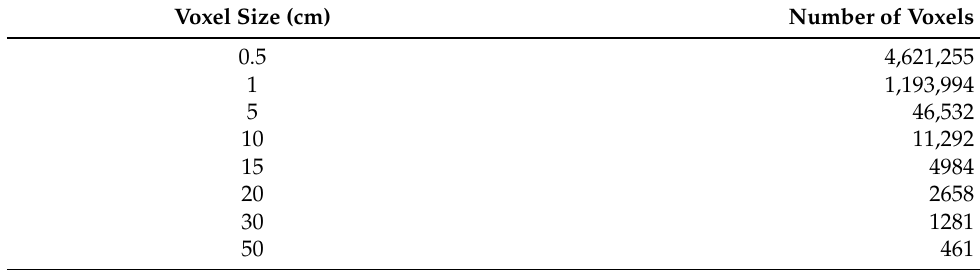
Table 4. Number of voxels relative to their